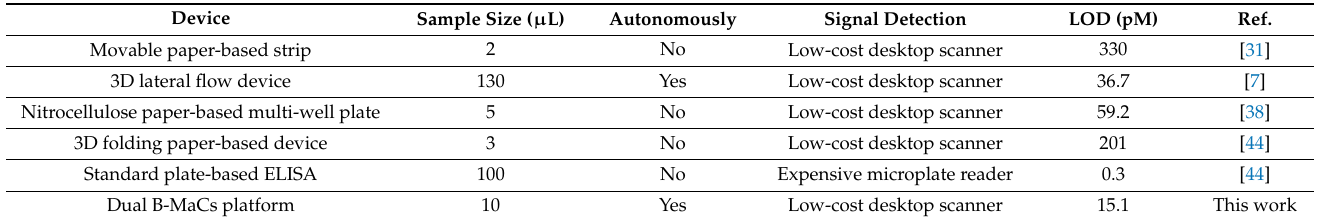
Table 2. Comparison of testing conditions and results attained by the paper-based ELISA platform presented in this study with previously reported